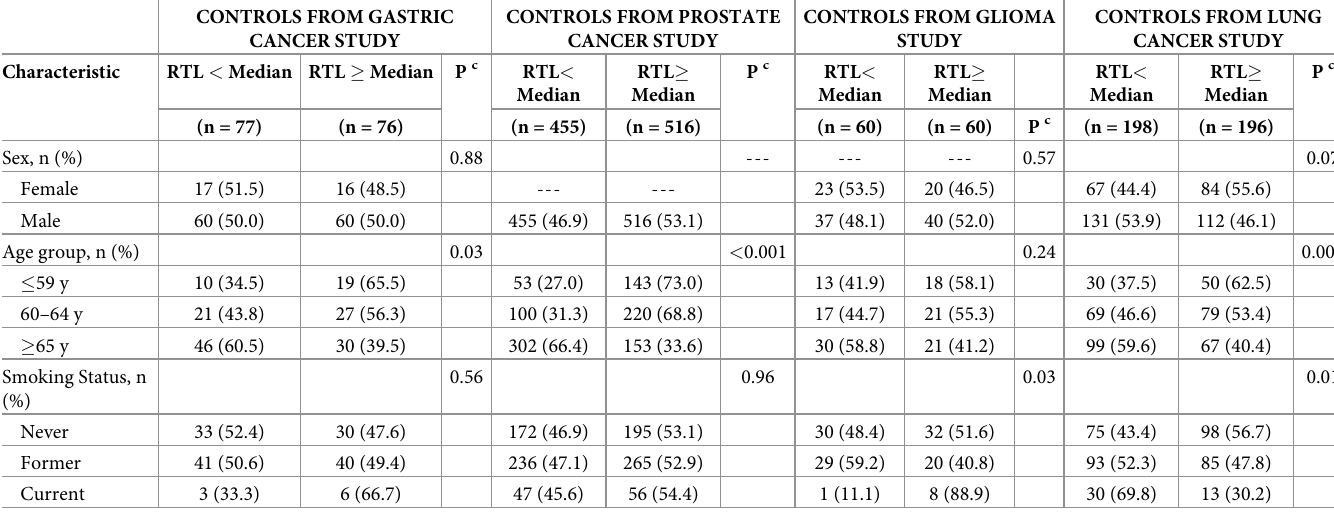
Table 2. Participant characteristics according to category of RTL a, b